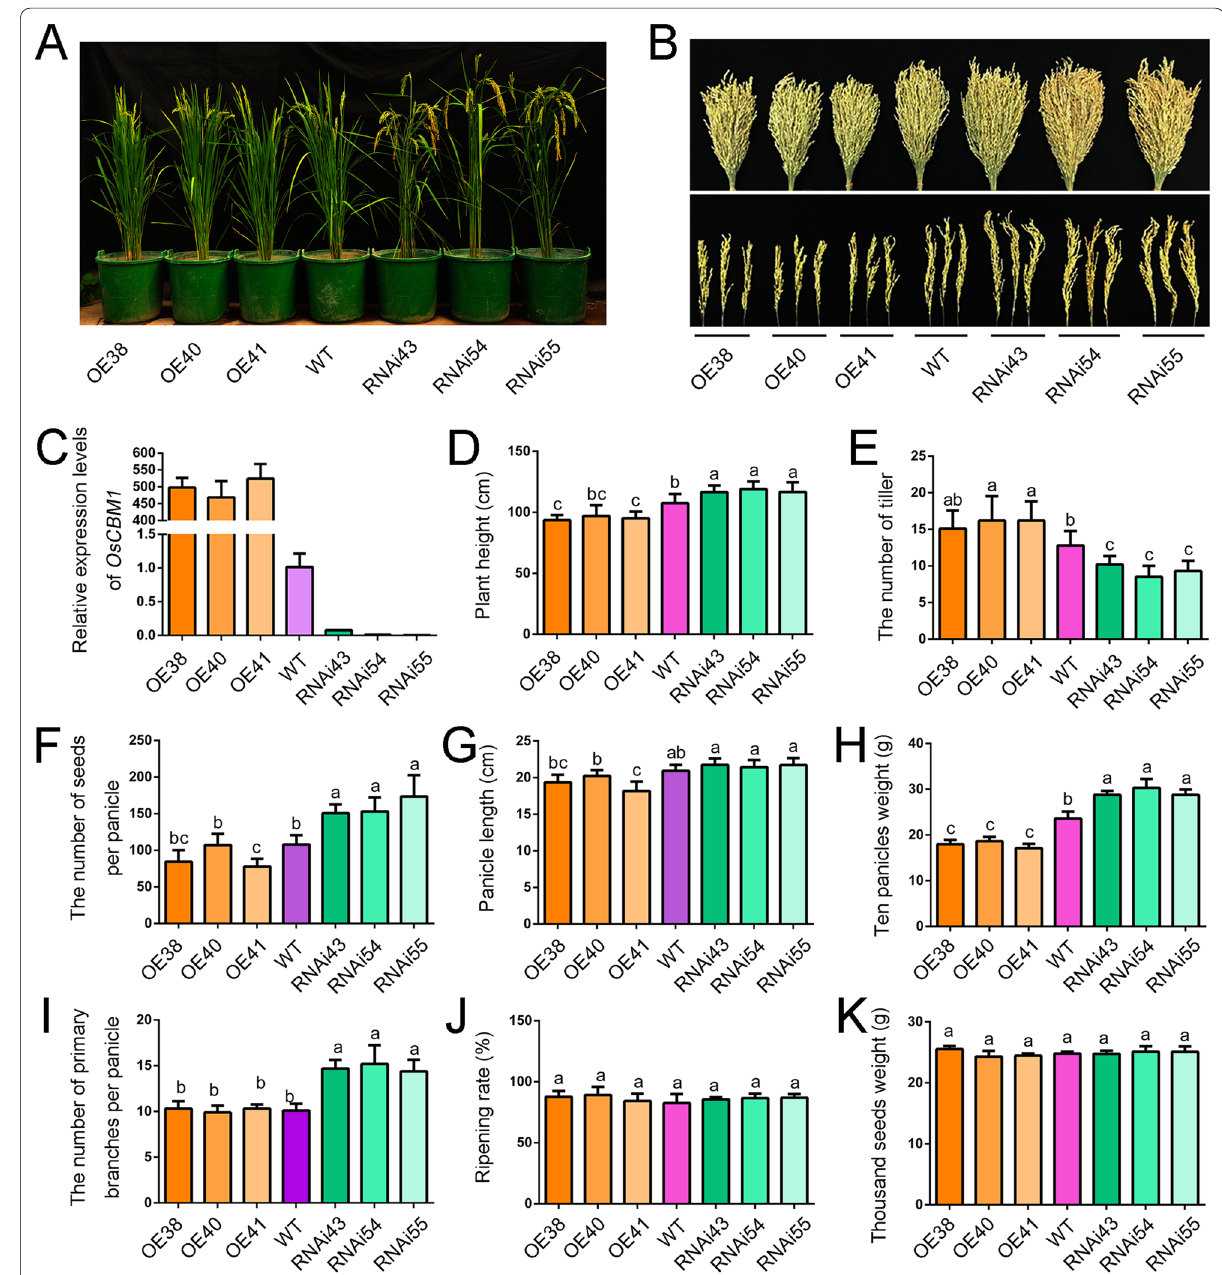
Fig. 2 Differential expression of OsCBM1 affected the morphology of rice plants and their agronomic traits. A Gross morphology of wild‑type (WT, Nipponbare) and the OsCBM1 ‑overexpressed (OE) or ‑RNA interference (RNAi) transgenic plants at heading stages. B Harvested panicle morphology of the different plant lines, the top picture showing the morphology of 20 panicles bundled together. C Transcriptional levels of OsCBM1 in the different plant lines at the heading stages detected by qRT‑PCR using OsActin1 as the internal control. D Plant height of the plants at the ripening stage. E The tiller numbers of the different plant lines. F – K Yield‑related parameters between the WT and OsCBM1 ‑transgenic plants. The plants were grown in pots filled with paddy soil under natural growth condition and at least 30 plants were used for the calculation of the agronomic traits. Bars annotated with different letters represent values that are significantly different ( p 0.05) according to a one‑way ≤